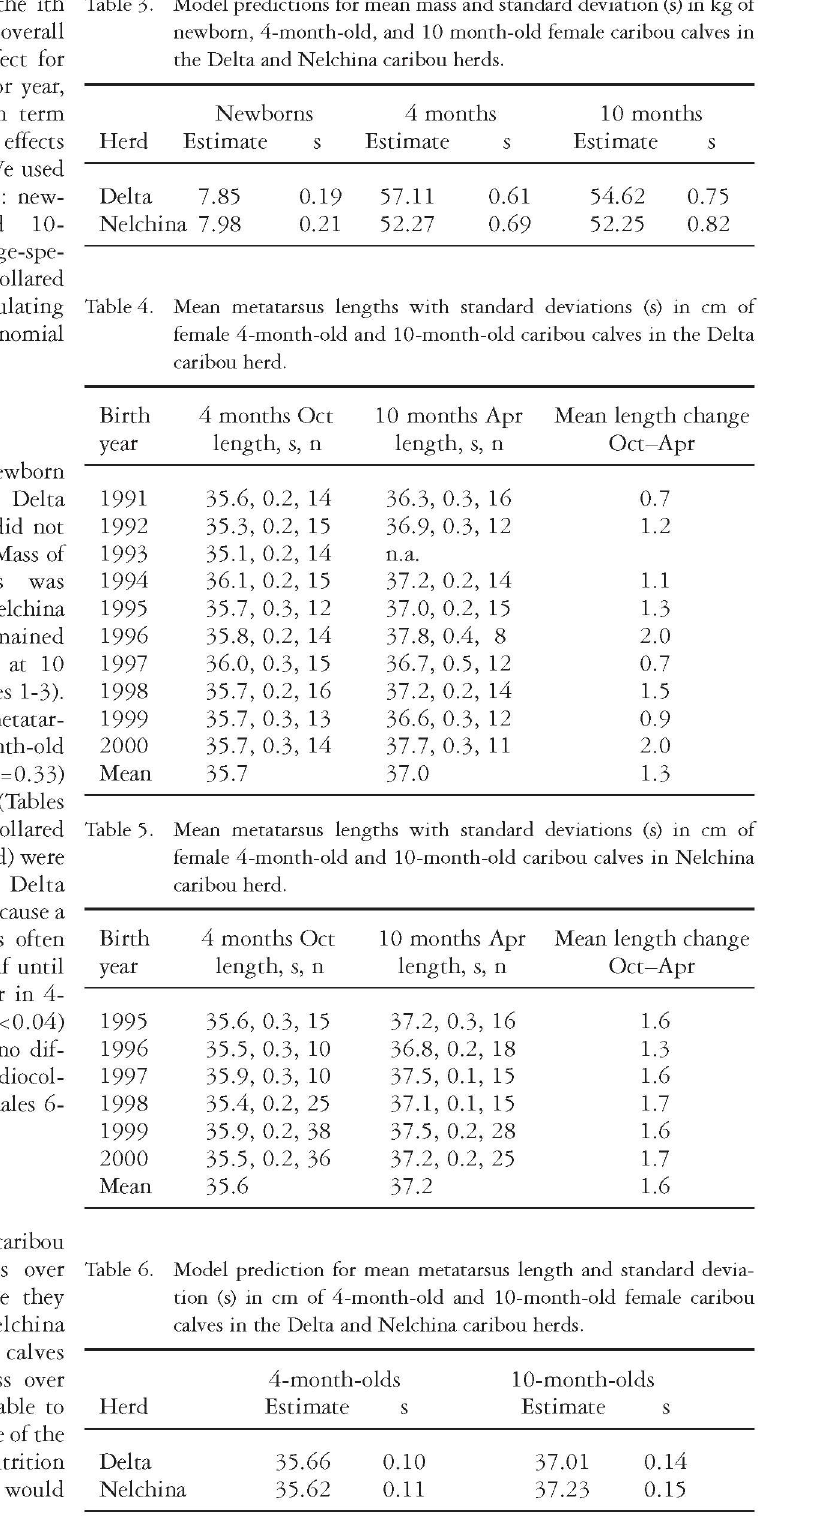
Table 6. Model prediction for mean metatarsus length and standard devia¬ tion (s) in cm of 4-month-old and 10-month-old female caribou calves in the Delta and Nelchina caribou